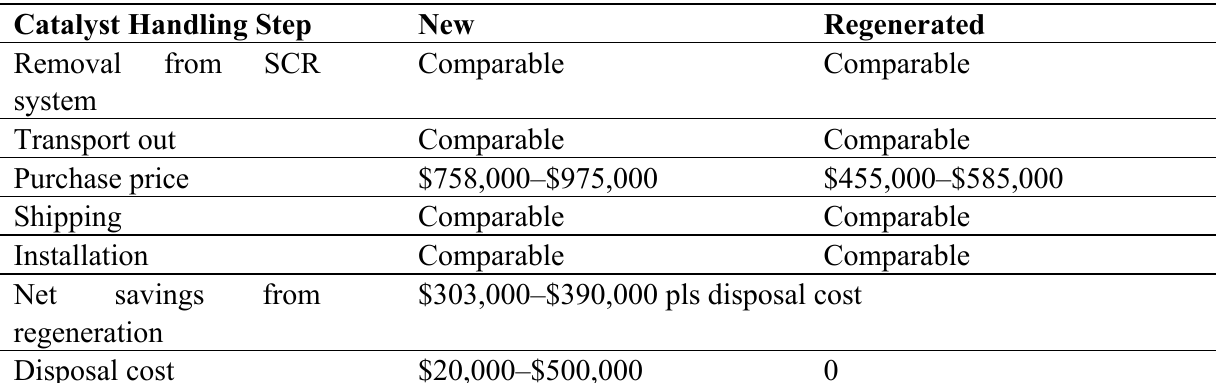
Figure 45. Concentration of principle poisons before and after regeneration. Reproduced from [320]. Courtesy CoaLogix, Inc. Table 21. Cost per layer (217 m 3 or 150 modules) of new versus regenerated SCR catalyst. Adapted from [322]. Copyright 2006, Electric